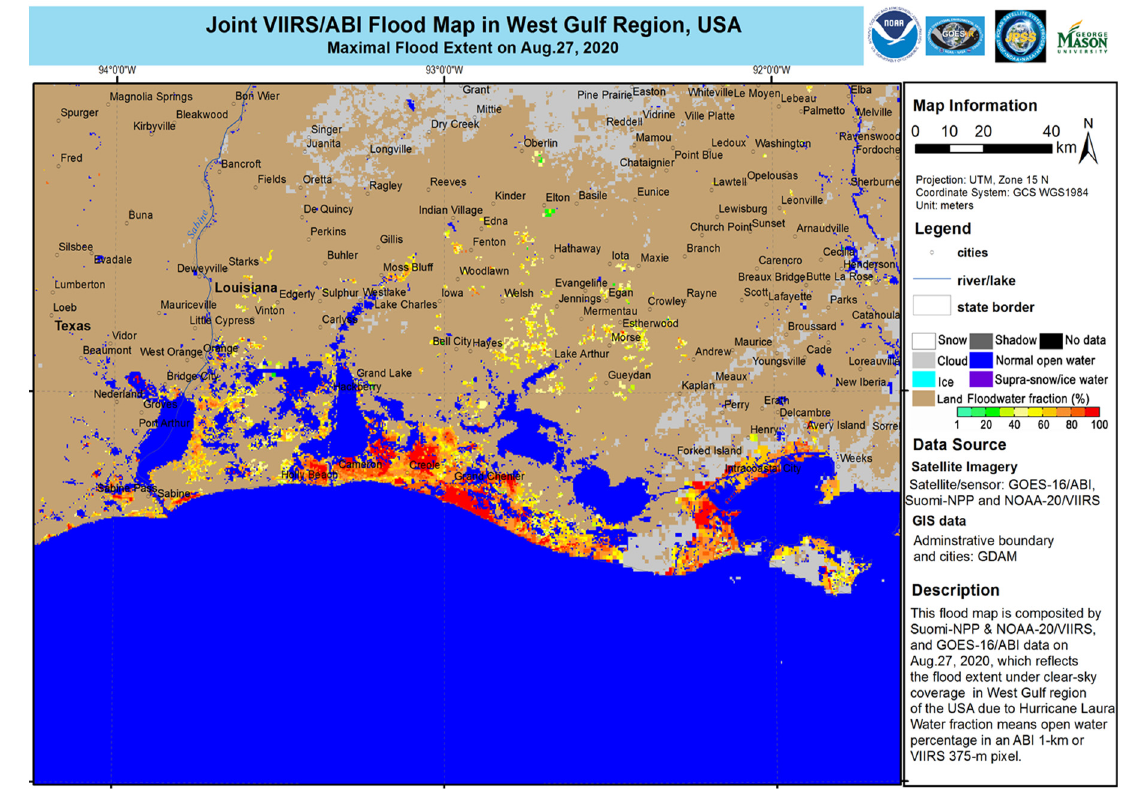
Figure 6. Blended VIIRS and ABI mapping of the flooding caused by Hurricane Laura in the West Gulf region on 27 August 2020.